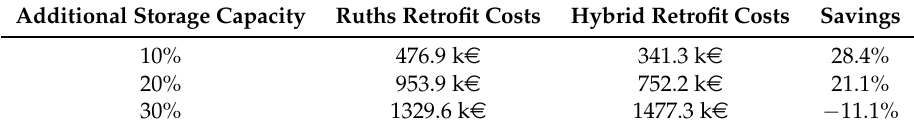
Table 9. Cost comparison of Ruths and PCM retrofit of seven 265 m 3 storage devices with 10 h charge/discharge time.